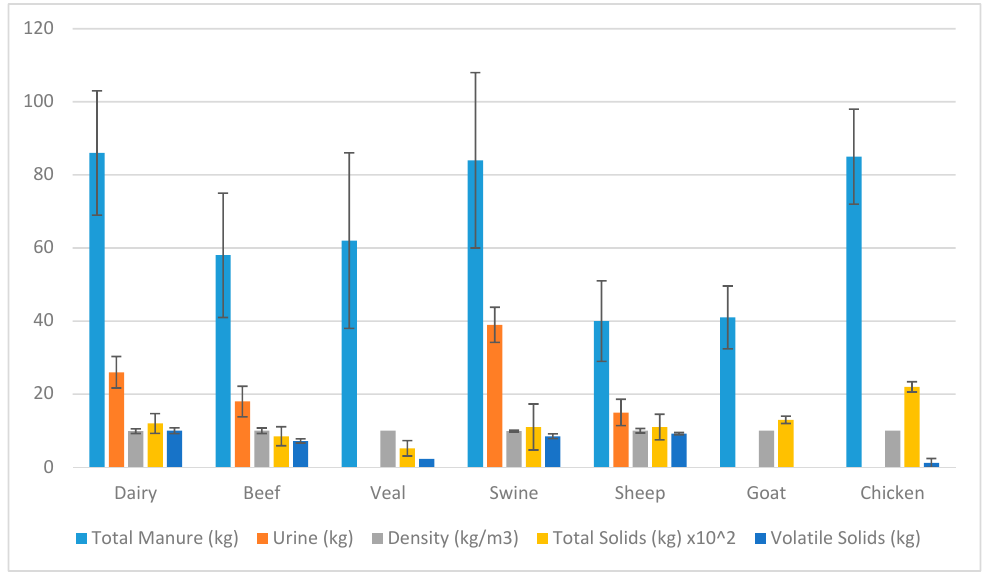
Figure 2. Fresh manure production and characteristics per 1000 kg of live animal mass per day.